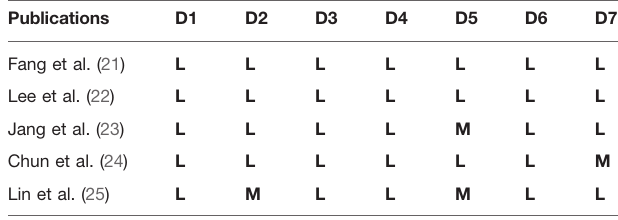
TABLE 3 | Evaluating the risk of bias in recruited studies using ROBINS-I (19).